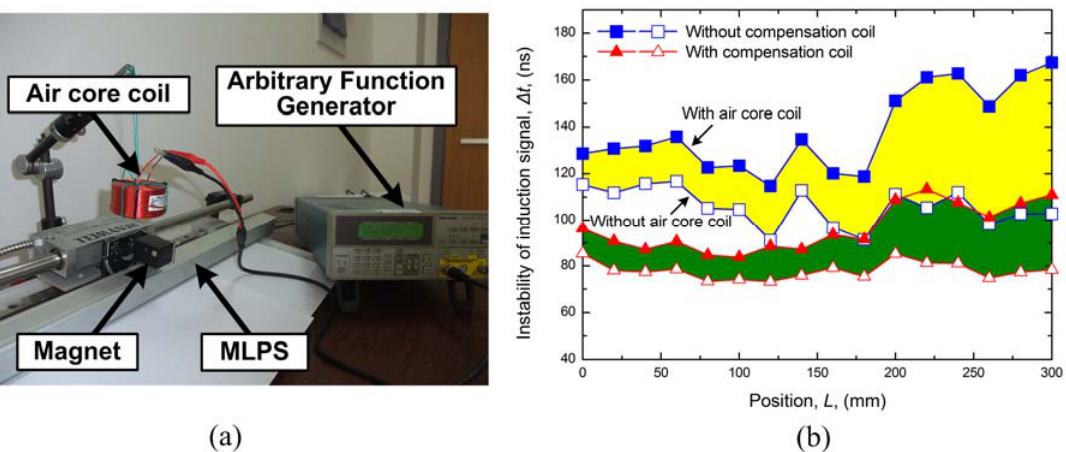
Figure 6. MLPS EMI suppression experiment with the air core coil ( a ) Experimental setup; ( b ) Comparison of induction signal instability with the perturbation.